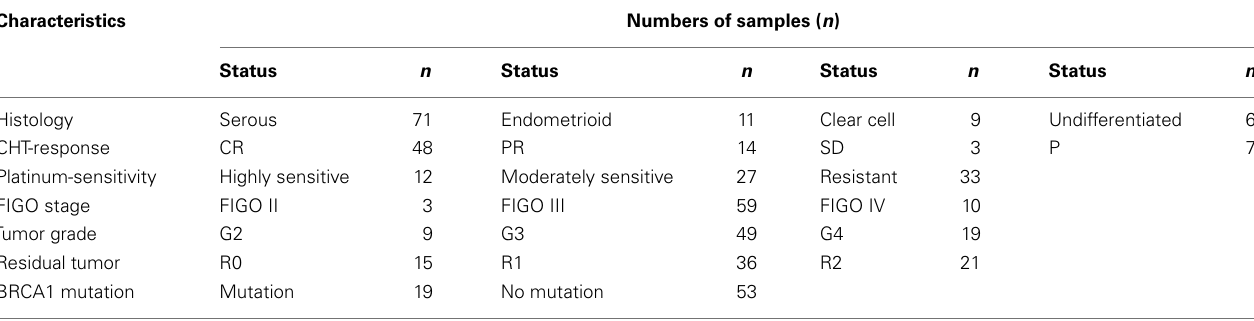
Table 1 | Characteristics of the group of patients and tumor samples